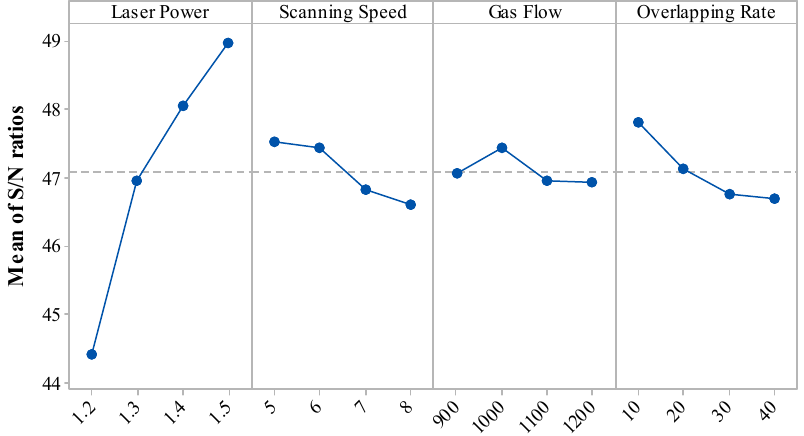
Figure 4. Main e ff ects plot for the S / N analysis of cladding e ffi Figure 4. Main effects plot for the S / N analysis of cladding efficiency.